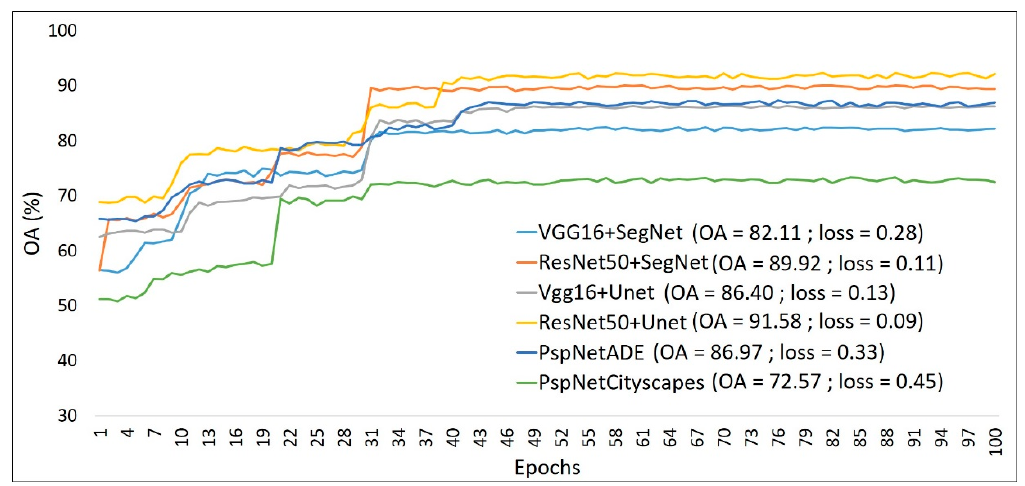
Figure 12. Overall accuracy over 100 epochs used for all CNN architectures for semantic segmentation of ecotopes in Clara Bog.